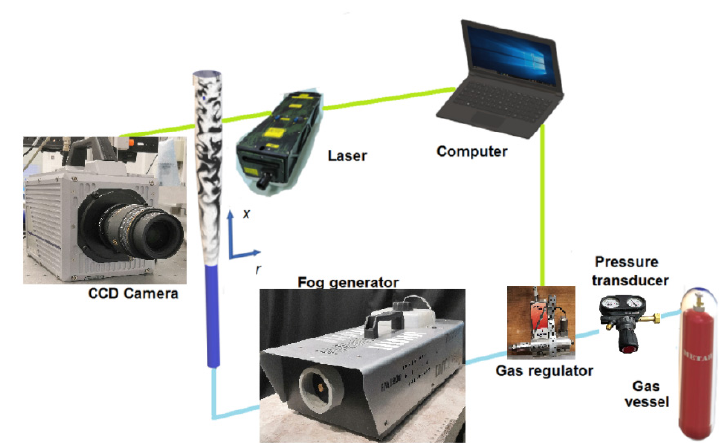
Figure 1. Experimental setup